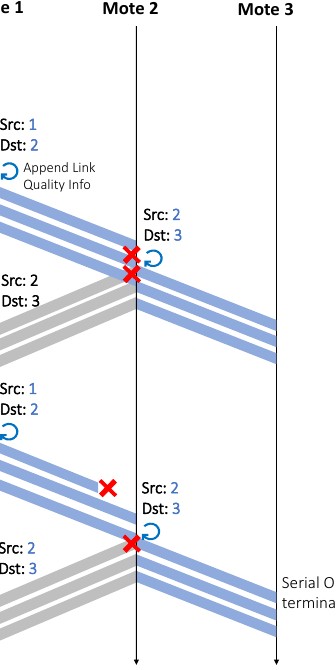
Figure 5. The communication protocol relays transmitted each received packet three times to increase reliability.